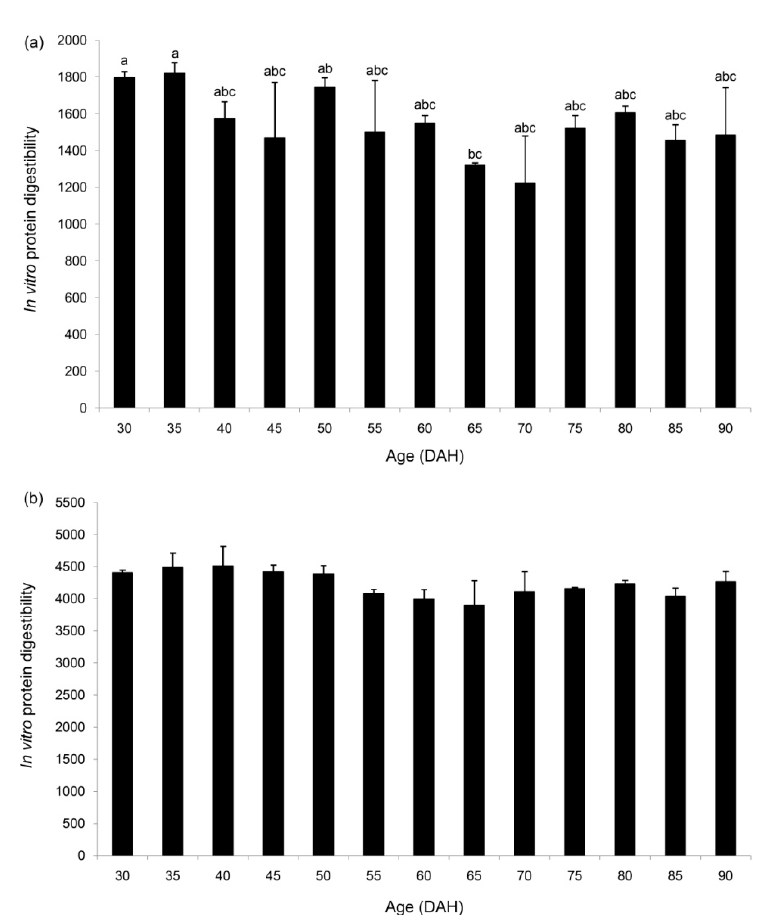
Figure 3. In vitro digestibility of protein ( µ mol DL -alanine equivalent g mealworm larvae − 1 ) in mealworm larvae using digestive enzyme extract from Nile tilapia ( a ), and from African catfish ( b ). Data are expressed as mean ± SEM from triplicate measurements. Significant differences between treatments are indicated by different superscripts ( p < 0.05). DAH stands for days after hatching.